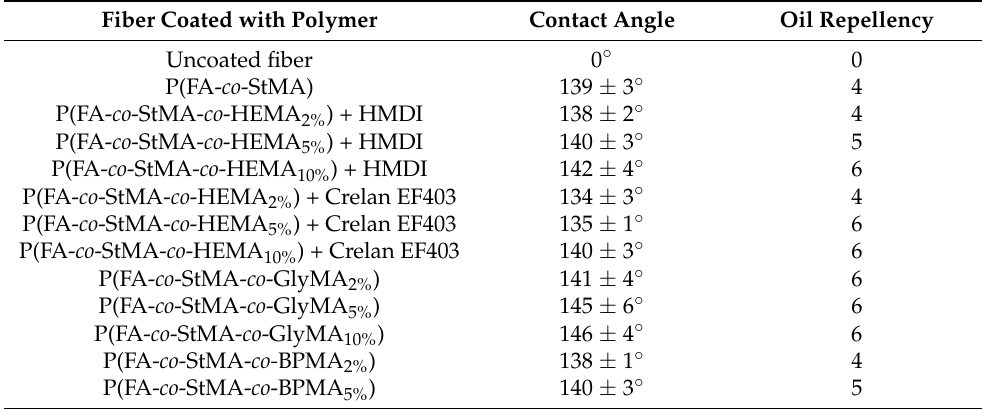
Table 3. Contact angles of water for the uncoated and coated cellulose fiber substrates, and the oil repellency of the fibers tested with the hydrocarbon test (4 = n -tetradecane, 5 = n -dodecane, 6 = n